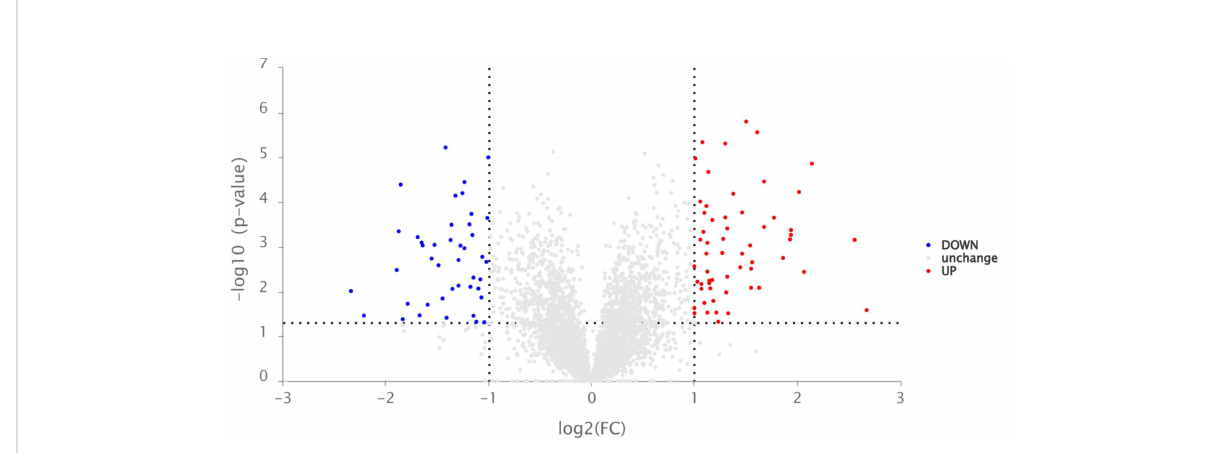
FIGURE 4 Volcano plot of the relative protein abundance changes between the “ A16 + TMV ” and “ CK + TMV ”